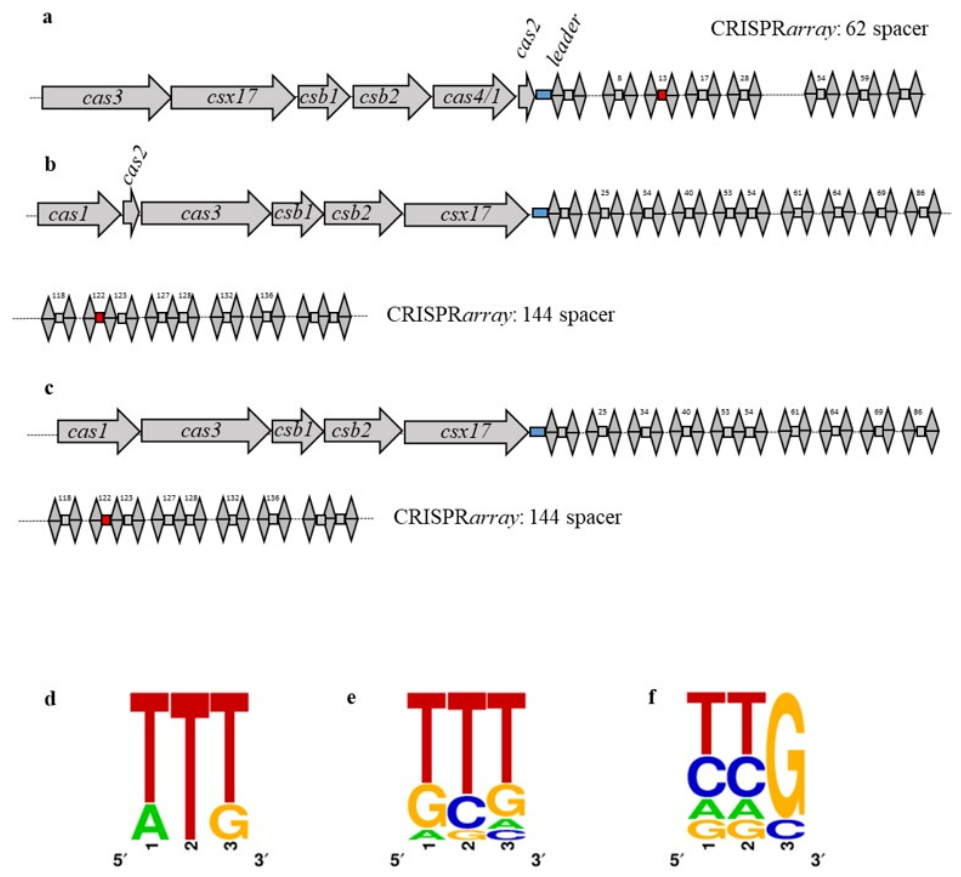
Figure 3. CRISPR/Cas system type I-U of M. bourgensis E02.3 and predicted PAM motifs: ( a ) CRISPR/Cas system in M. bourgensis E02.3 contig 7. It consists of the genes for Cas3, Csx17, Csb1, Csb2- and Cas4/1-fusion, and Cas2. The array includes 63 directed repeats with a length of 36 nt, which were arranged alternately with spacers. ( b ) CRISPR/Cas system in M. bourgensis MAB1 type I-U_I, and ( c ) CRISPR/Cas system in M. bourgensis MS2 T type I-U_I. They consist of the genes for the Cas proteins Cas1, (only M. bourgensis MAB1, Cas 2), Cas 3, Csb1, Csb2, and Csx 17. The arrays are identical, including 144 spacers and the same direct repeats as the M. bourgensis E02.3 type I-U system. PAM motifs were predicted by manual curation of the Blf4 specific spacers for the strains ( d ) M. bourgensis E02.3, ( e ) M. bourgensis MS2 T , and ( f ) M. bourgensis MAB1. Only one common spacer against Blf4 was identified (indicated in red). The leader sequence is marked in blue.